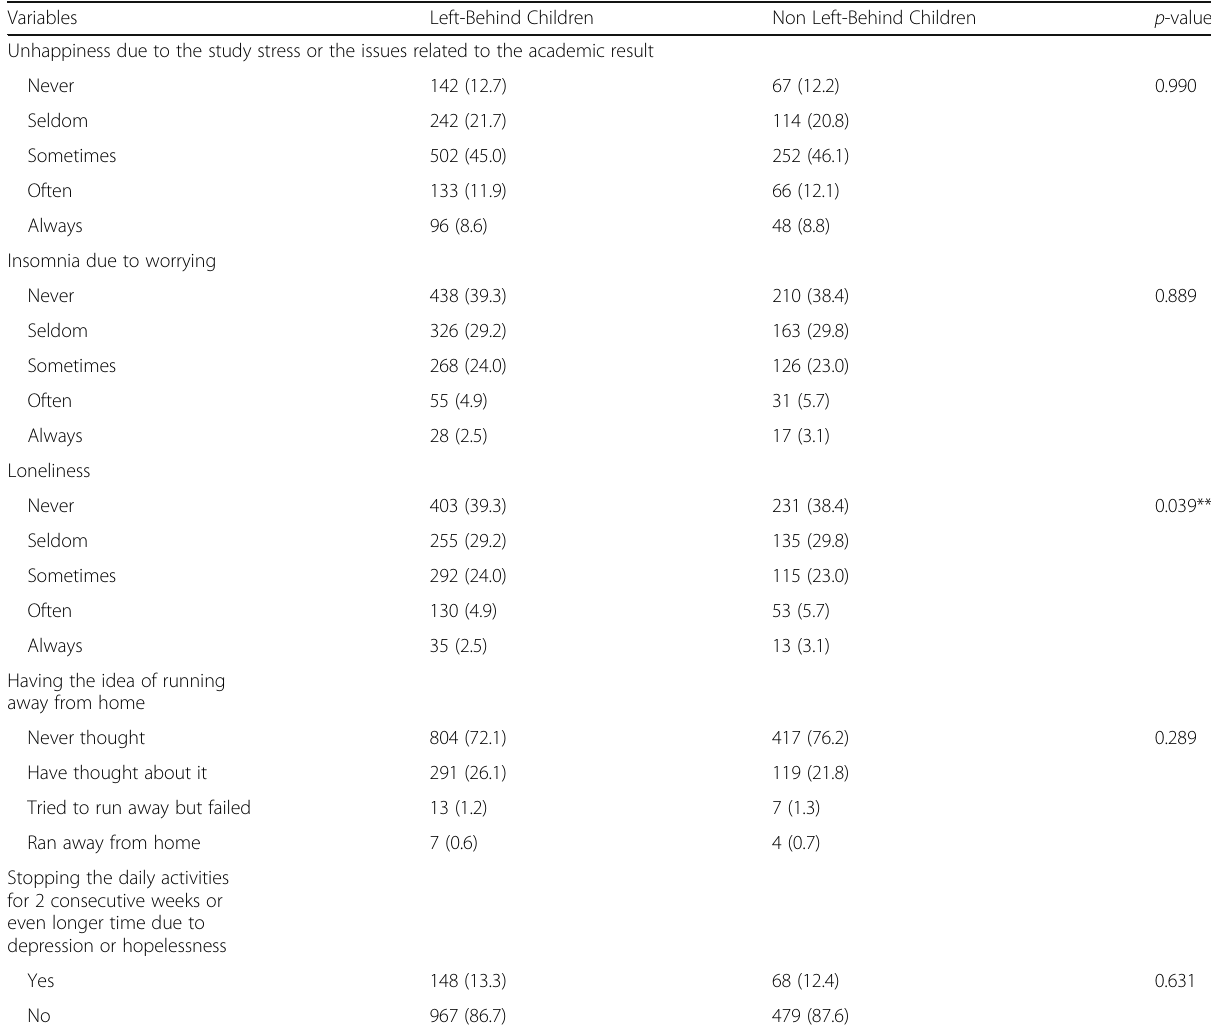
Table 4 Mental health variables of the participants between left-behind children group and non left-behind children group Variables Left-Behind Children Non Left-Behind Children p -value Unhappiness due to the study stress or the issues related to the academic